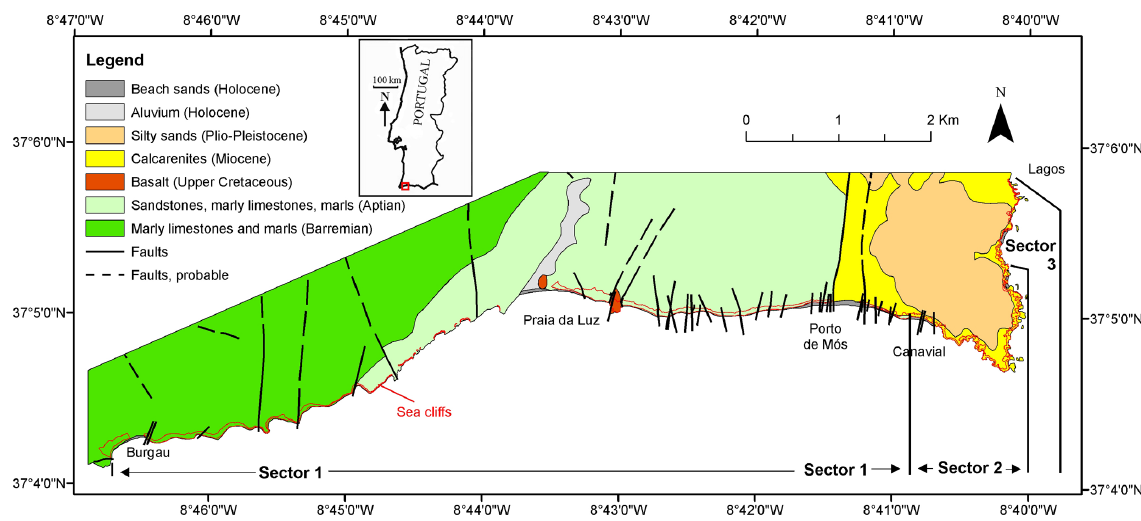
Fig. 1. Localization and main lithological units, faults and sea cliff extent (red lines) in the study area. Sectors defined according to space frequency of cliff failures and corresponding planimetric area lost at the cliff top and lithology (Fig.